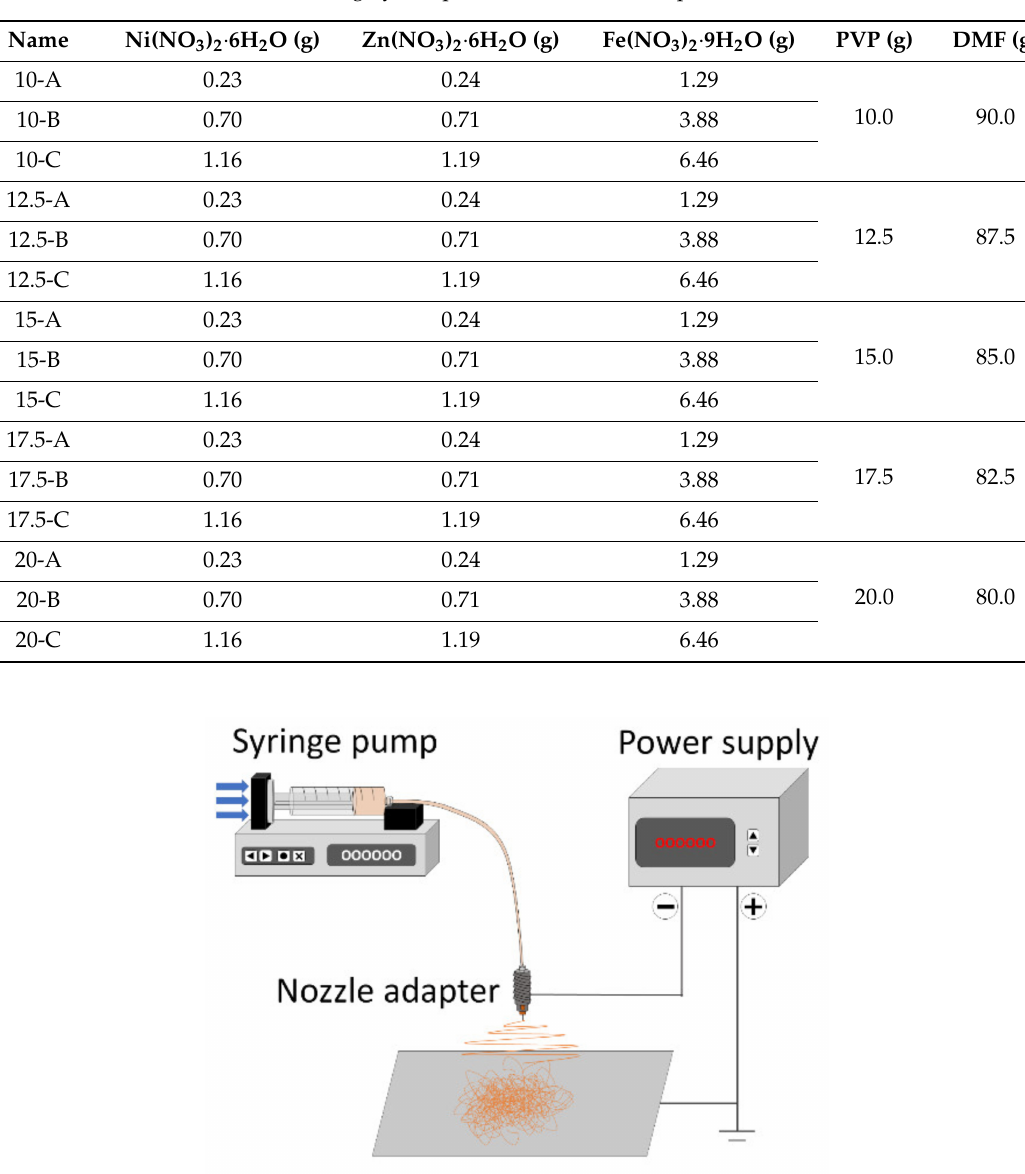
Table 1. The naming by composition and content of precursor solutions.